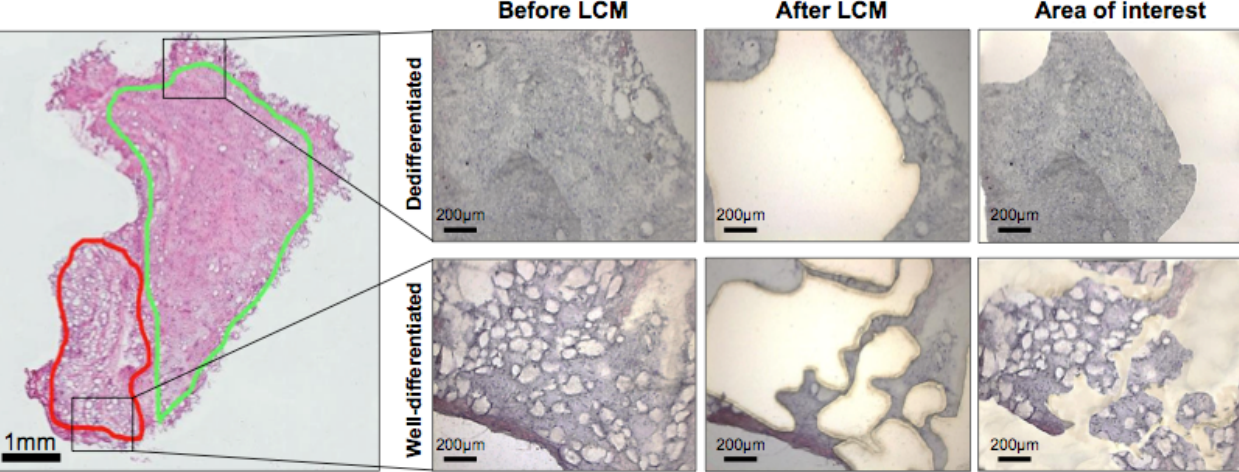
Figure 1. Representative sample of a liposarcoma with mixed well-differentiated liposarcoma (WDLS) and dedifferentiated liposarcoma (DDLS) components selected for laser-capture microdissection (LCM). Digitised haematoxylin and eosin (H&E) images were annotated by the clinical pathologist to identify well-differentiated (WD) (green) and dedifferentiated (DD) (red) regions. LCM, laser-capture microdissection. Scale bar: 1 mm (whole sample on left) or 200 µm (LCM samples on right).